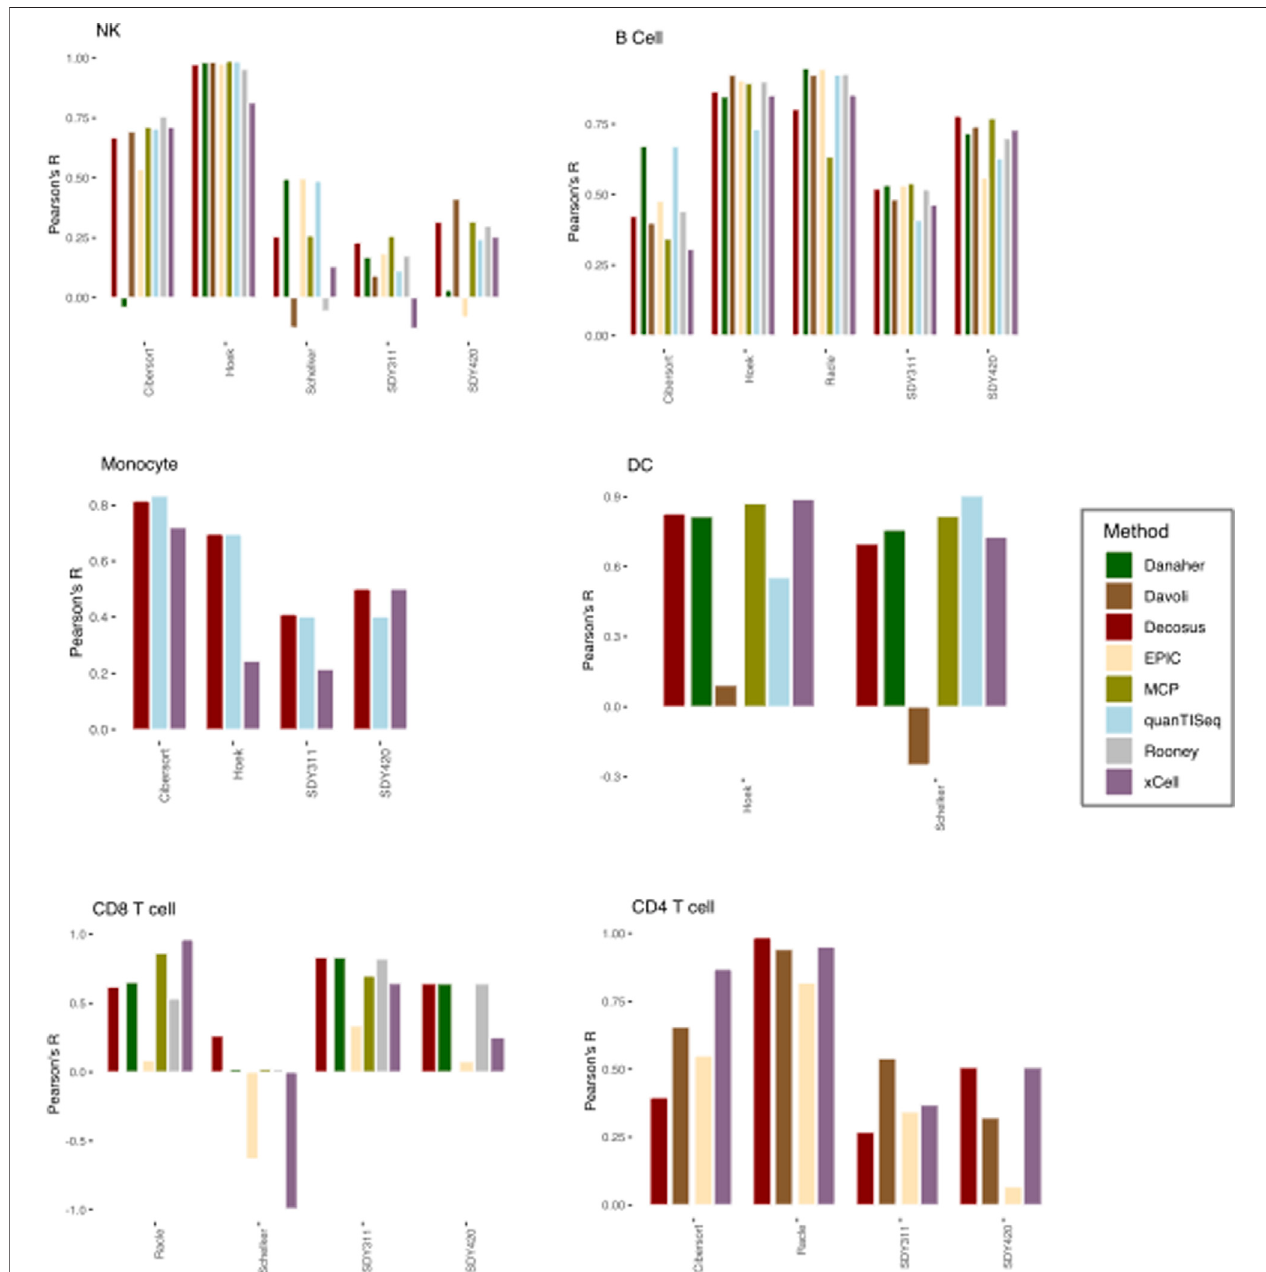
FIGURE 2 | Decosus identi fi es known cell fractions. Bar plots of the Pearson ’ s R of the correlation between computer-generated cell fractions and fl ow cytometry fractions. The higher the R, the more similar is the computational estimates and the gold standard. Within the plots colours represent the method of estimating cell fractions from bulk RNA-Seq datasets. MCP =